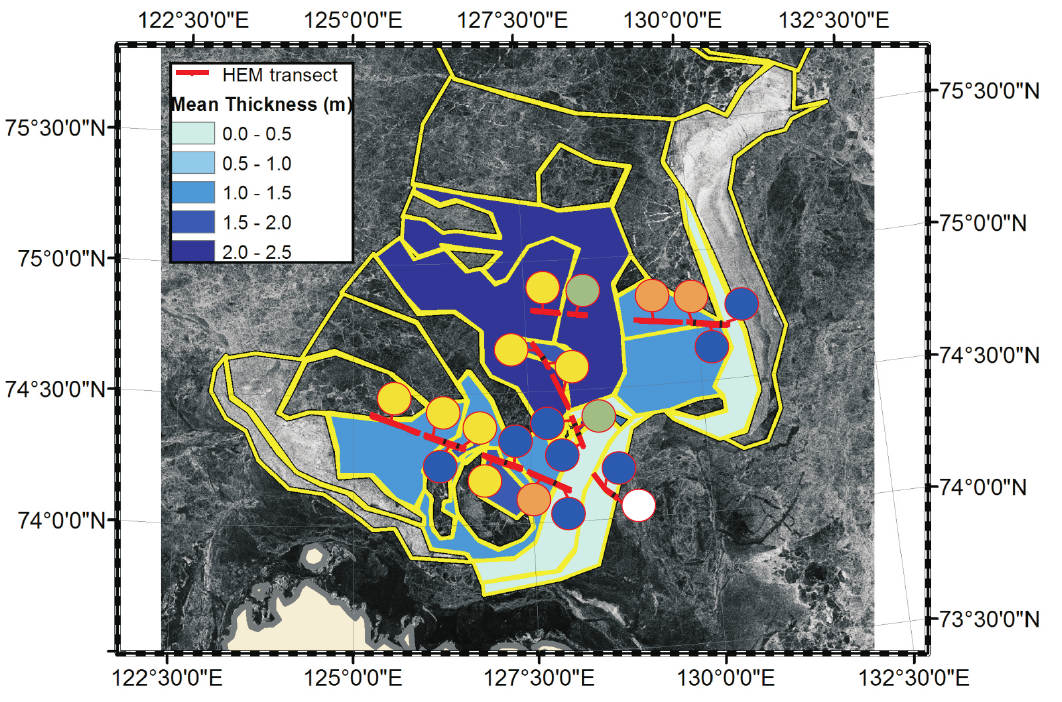
Fig. 5. Map with all HEM sea-ice thickness profiles. Northern and southern profiles flown on 14 and 16 April are coded 14a–m and 16a–h, respectively. Circle colors refer to the polynya events in which the respective surveyed sea ice formed (for color code, see Table 1). The yellow lines on the SAR map show a classification of the survey area in zones of the same age. The blue colors refer to the mean thickness of the corresponding HEM cross profile. Table 1. Parameters of sea ice originated during the four polynya events, estimated for the state on 14–16 April.